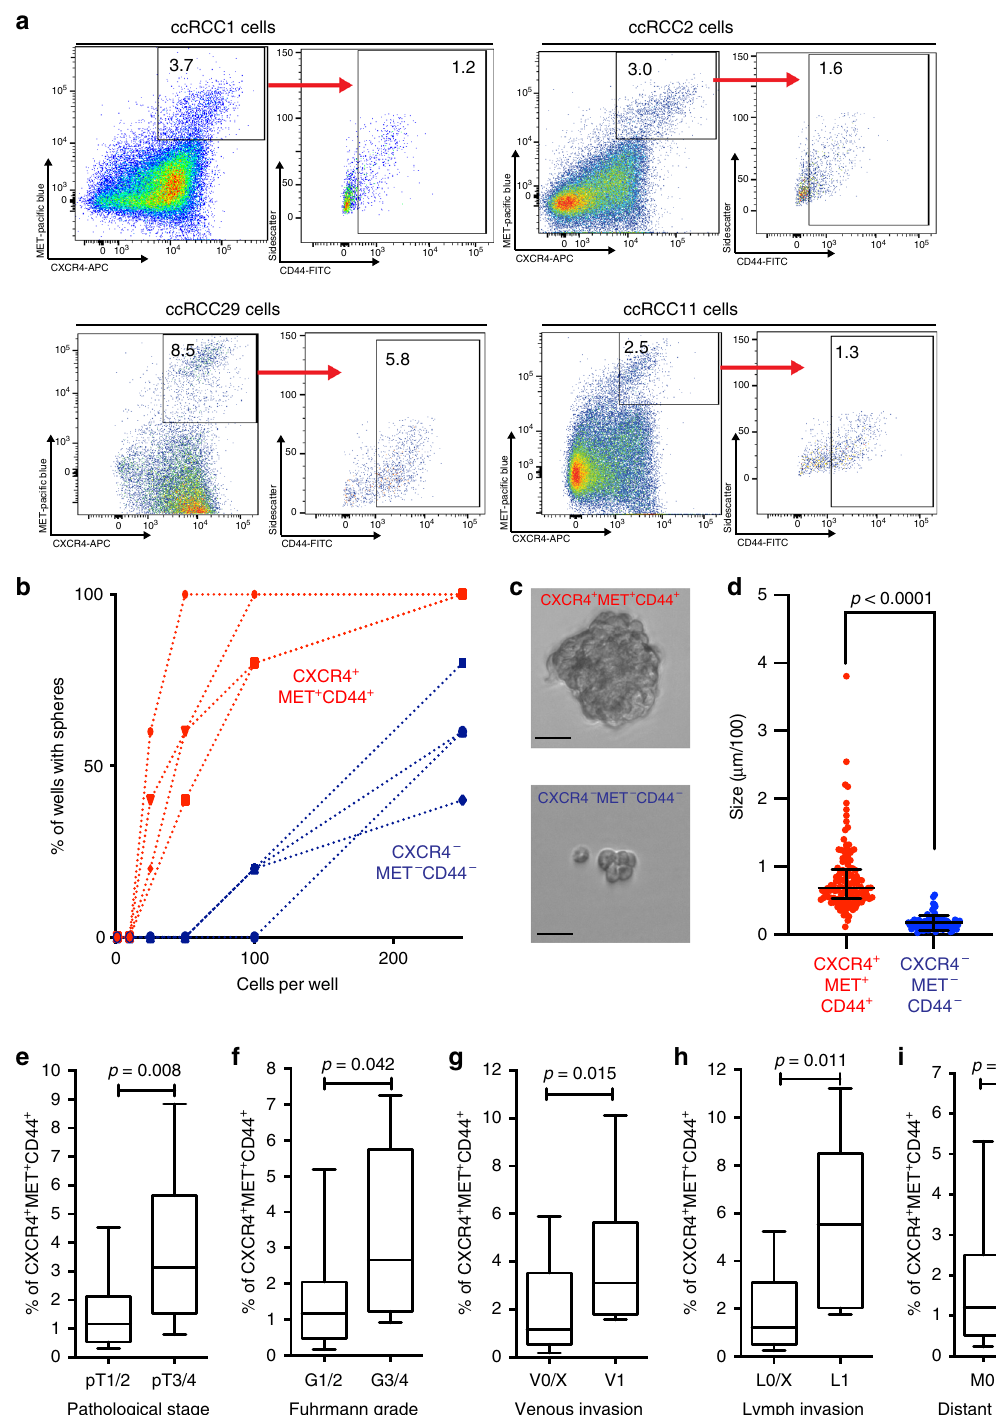
Fig. 1 Analysis of ccRCC cancer stem cells. a Representative FACS of single-cell suspensions of ccRCC cells using the markers CXCR4, MET, and CD44. Axis label of sidescatter is a multiple of 1000. b Limiting dilution assay of the sphere formation capacity of CXCR4 + MET + CD44 + and CXCR4 − MET − CD44 − cells ( n = 4, single-cell suspensions of independent patients): 1 – 250 cells per well were seeded and cultured for 7 days, and all wells with >1 sphere were counted as positive. 10 wells per concentration were analyzed. c Representative image of spheres of the two phenotypes after 7 days of culture (Scale bar, 25 µ m) ( n = 4, single-cell suspensions of independent patients). d Quanti fi cation of sphere size of CXCR4 + MET + CD44 + and CXCR4 − MET − CD44 − cells after 7 days of culture ( n = 125 CXCR4 + MET + CD44 + spheres and 83 CXCR4 − MET − CD44 − spheres). Shown is the diameter in µ m/100, line represents median size and error bars show the interquartile range. p -value was calculated by two-sided Mann – Whitney test. Frequencies of CXCR4 + MET + CD44 + cells in ccRCCs from patients with (e) pathological stage (pT) 1/2 ( n = 22) or 3/4 ( n = 19), ( f ) Fuhrman grade (G) 1/2 ( n = 34) or 3/4 ( n = 7), ( g ) without ( n = 31) or with ( n = 10) venous invasion (V), ( h ) without ( n = 34) and with ( n = 7) lymph node invasion (L), and ( i ) without ( n = 33) or with ( n = 8) distant metastases (M) at the time of surgery. Numbers represent single-cell suspensions of individual patients. Boxes show the 25, 50, and 75 percentiles, whiskers the 10 and 90 percentiles. Outliers are shown as dots. p -values were calculated by two-sided Mann – Whitney